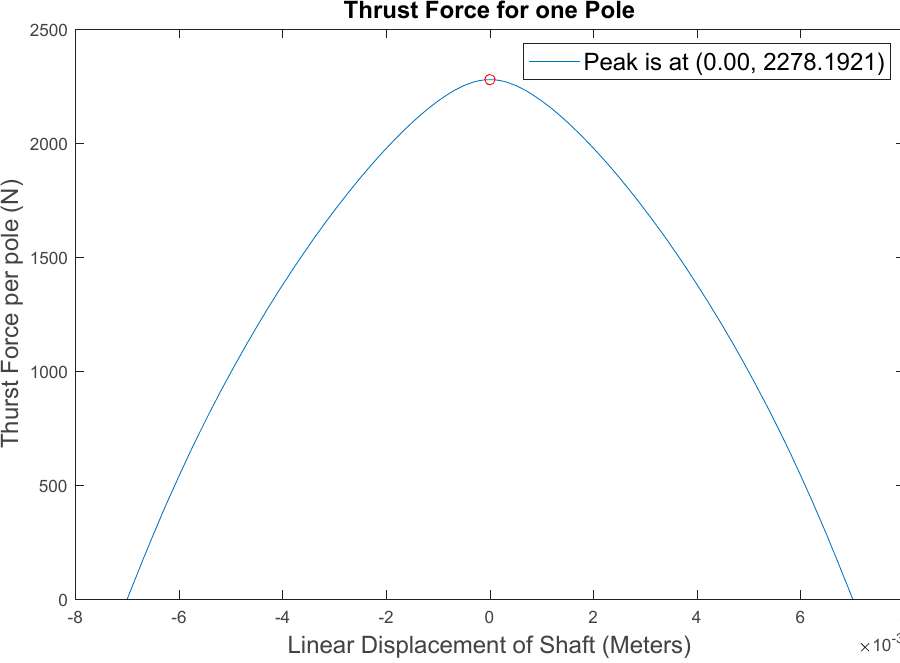
Figure 16. Thrust force as a function of axial displacement—Calculated using (33).